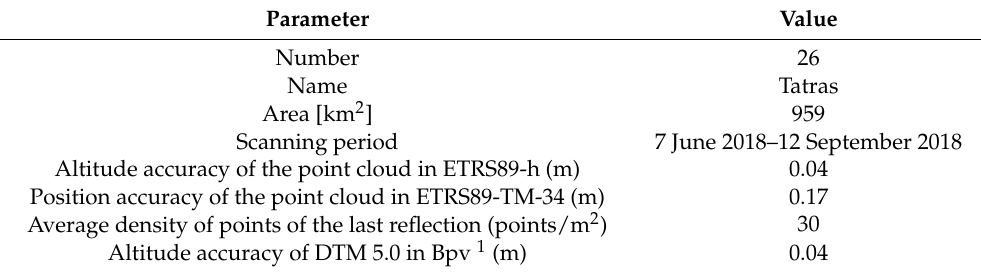
Figure 1. ( a ) Study area: Slovak part of the Tatra Mountains in the range of zone 26 of LiDAR data provided by [45]. Data sources: ÚGKK SR [45], © OpenStreetMap contributors [46,47]. ( b ) View of the study area (photographed from the Low Tatras). ( c ) Local view. Photo: R. Ď . Table 1. The parameters of ALS data collection from the study area (number 26: Tatras). Data source: [51].